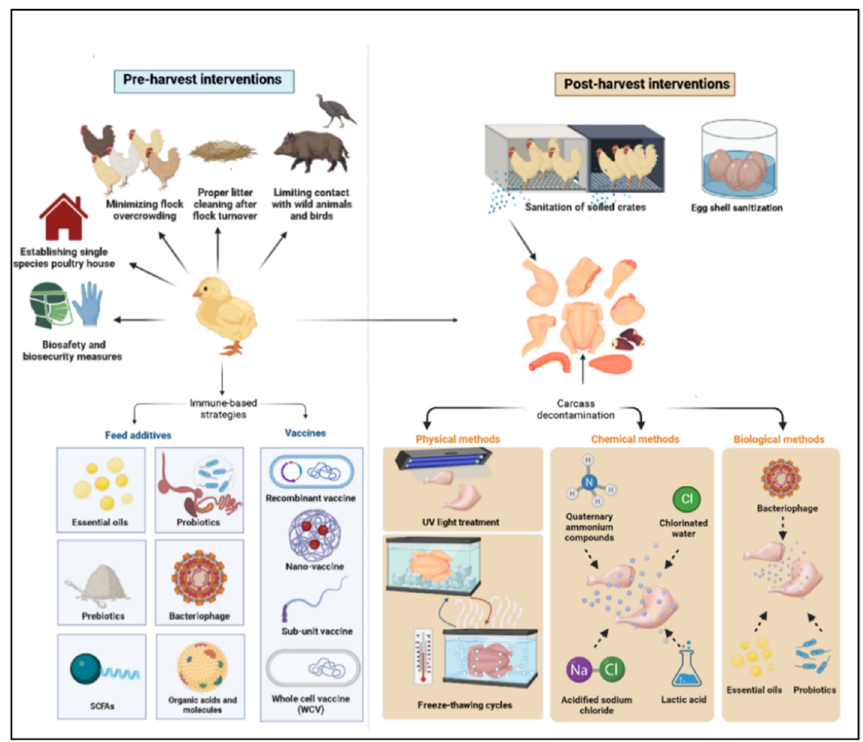
Figure 1. Pre- and post-harvest control measures.